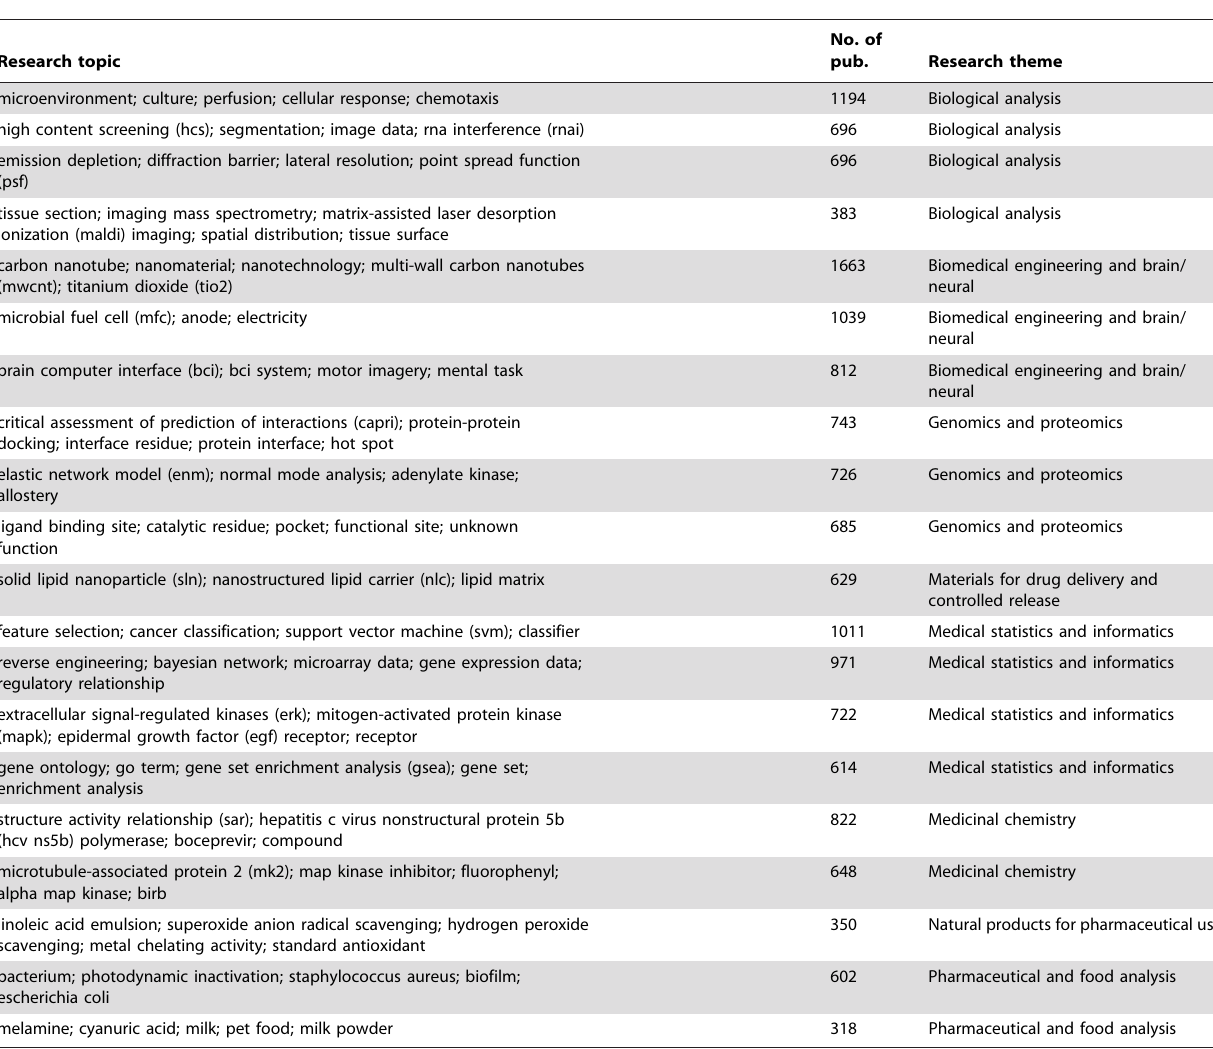
Table 4. The 20 research topics at the EPS-HLS interface with the most significant growth in publication output.